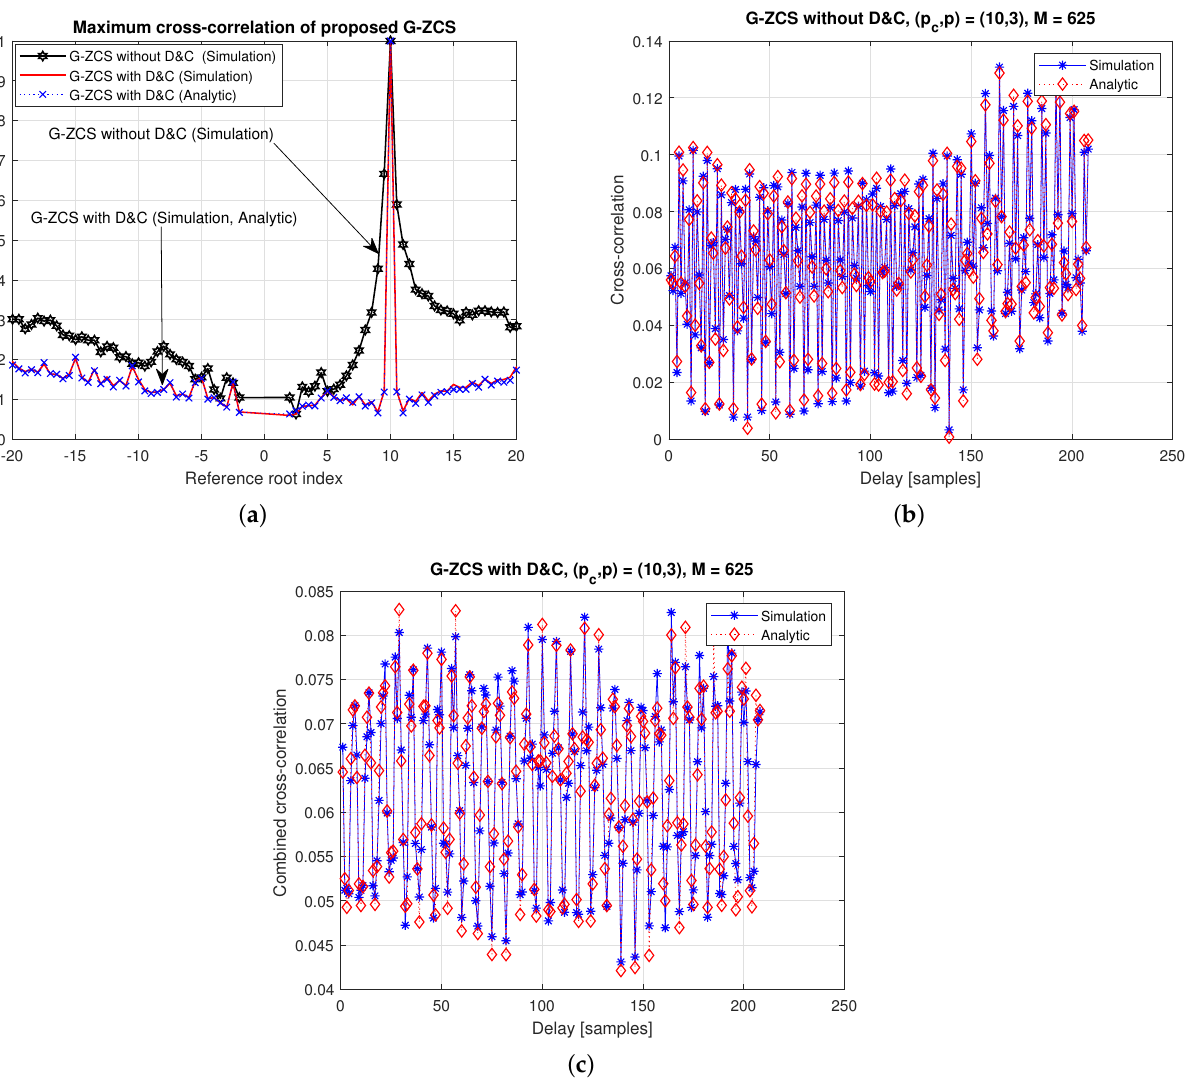
Figure 5. ( a ) Maximum cross-correlation of the proposed G-ZCS with different p values. ( b ) Cross-correlation value of the proposed G-ZCS as a function of delay (samples). ( c ) Cross-correlation value of the proposed G-ZCS as a function of delay